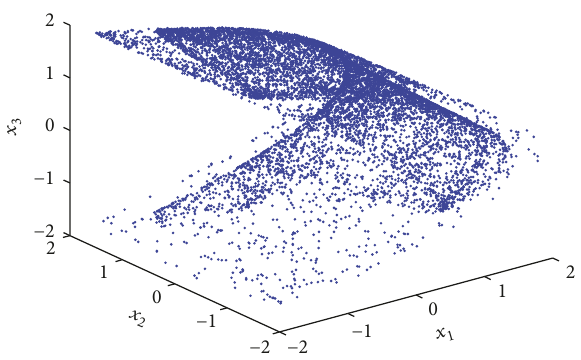
Figure 3: Attractor of the generalized H´enon map.